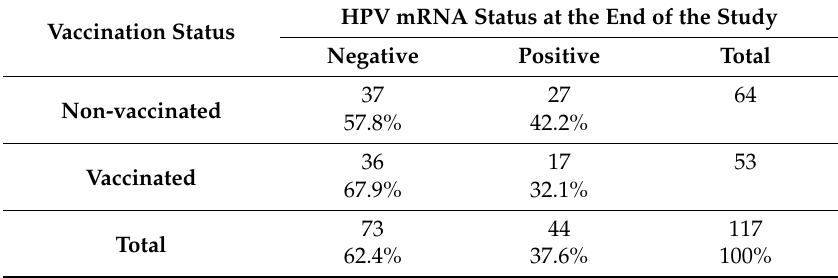
Table 5. HPV mRNA status at the end of the study for the overall population grouped into vaccinated and non-vaccinated women. For each group, the top row of each cell represents the number of cases, while the lower row represents the percentage of cases being HPV mRNA-negative or